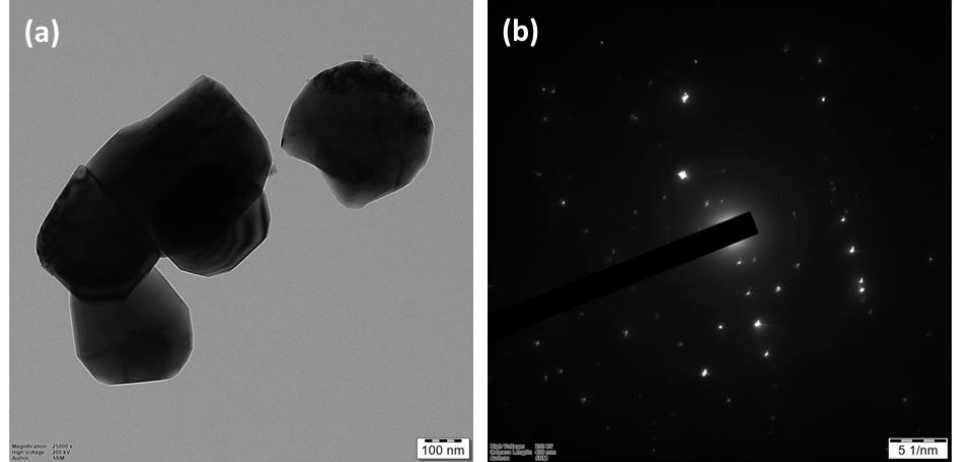
Figure 3. ( a ) HR-TEM image and ( b ) SAED pattern of MAL-CNPs.